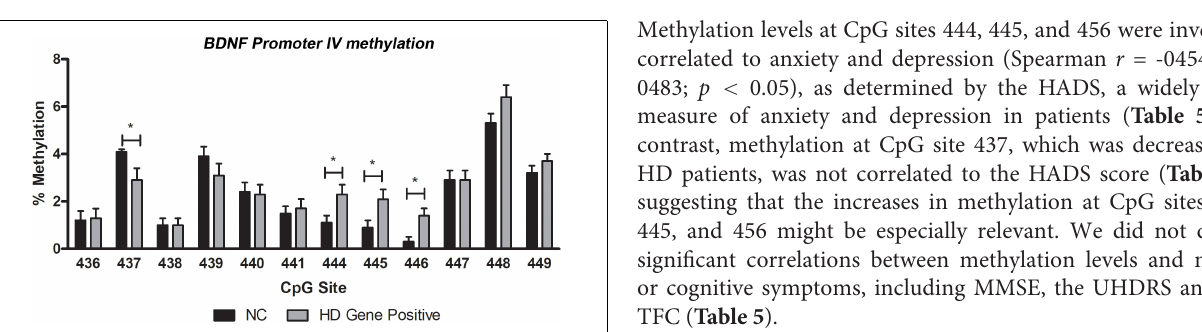
FIGURE 4 | DNA methylation levels of BDNF promoter IV in blood. Methylation was quantified by pyrosequencing and expressed as mean percent methylation representing the averaged value of cases (HD Gene+) or control subjects (NC) for each of individual CpG. Data represents mean value ± SEM. ∗ p < 0.05 as per two-tailed Student’s t